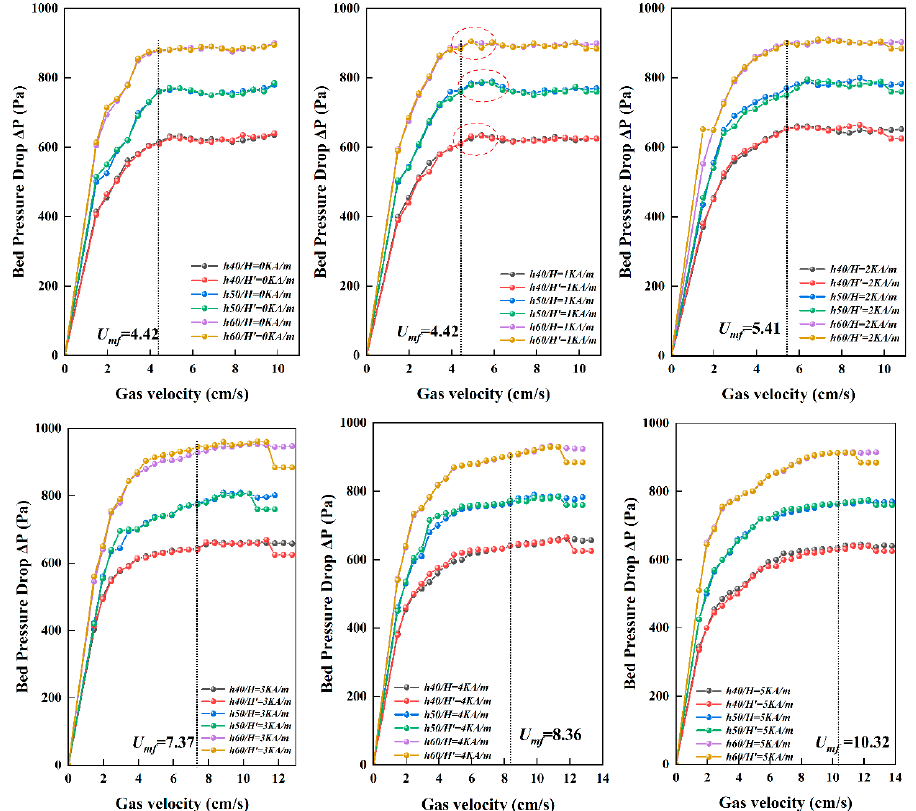
Figure 5. Particle fluidization curves of different adding sequence of magnetic field.